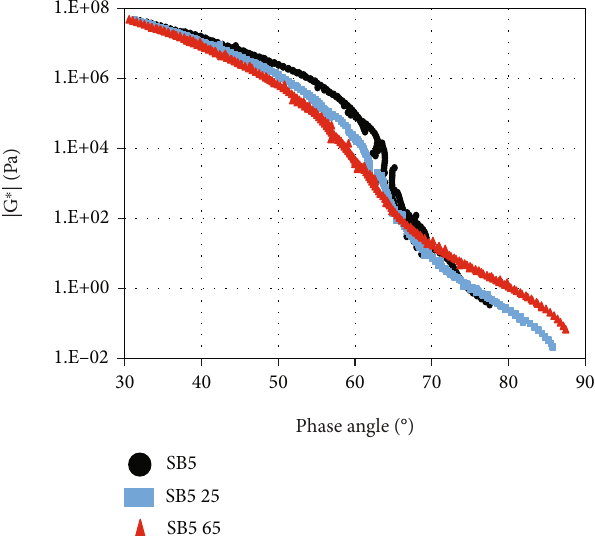
Figure 2: Black diagram of SB5 at di ff erent levels of aging.